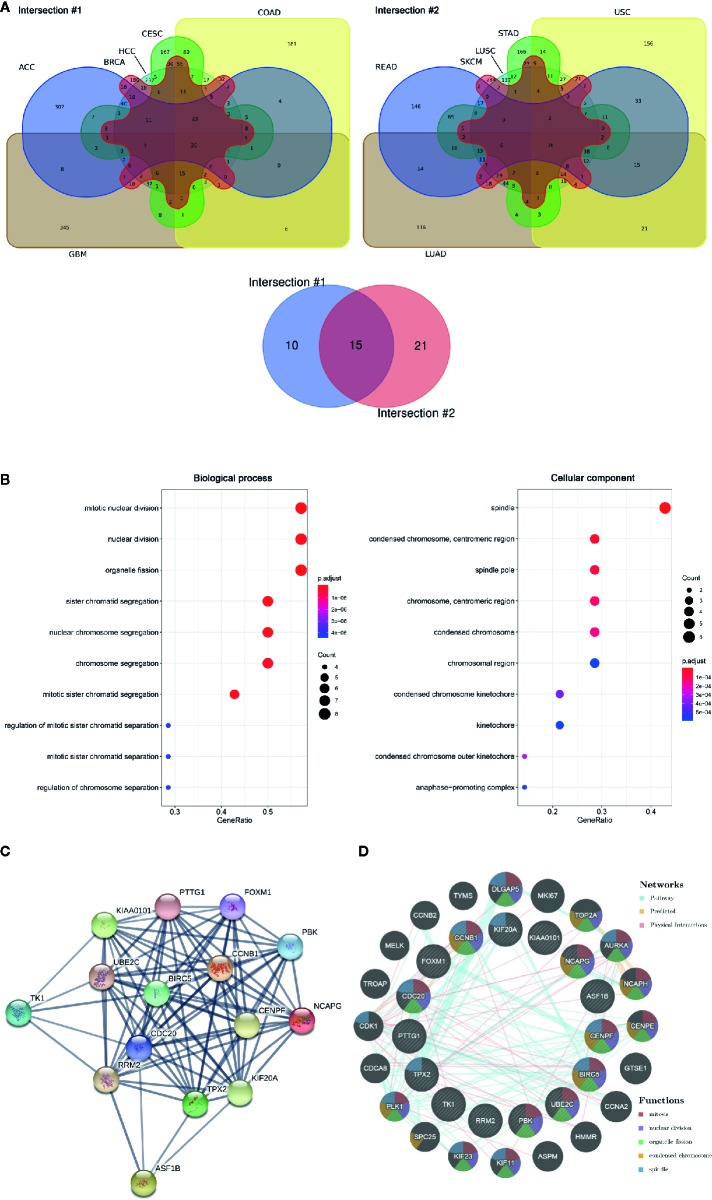
The aberrantly expressed genes identified across cancer types. (A) Venn diagram of deferential gene expression across various tumor types based on TCGA and GTEx projects via GEPIA (http://gepia.cancer-pku.cn/index.html). ACC, adrenocortical Carcinoma; BRCA, breast invasive carcinoma; CESC, cervical squamous cell carcinoma and endocervical adenocarcinoma; COAD, colon adenocarcinoma; GBM, glioblastoma multiforme; HCC, hepatoma carcinoma; LUAD, lung adenocarcinoma; LUSC, lung squamous cell carcinoma; READ, rectum adenocarcinoma; SKCM, skin cutaneous melanoma; STAD, stomach adenocarcinoma; UCS, uterine carcinosarcoma. (B) GO of 15 aberrantly expressed genes across tumor. Biological process, Cellular component. (C) PPI network was drawn using STRING online tool and the interaction score was set to high confidence (0.700). Network nodes represent proteins and edges represent protein-protein associations. (D) Pathway/predication/physical interaction analysis of genes according to human expression data in Gene MANIA (http://genemania.org/).